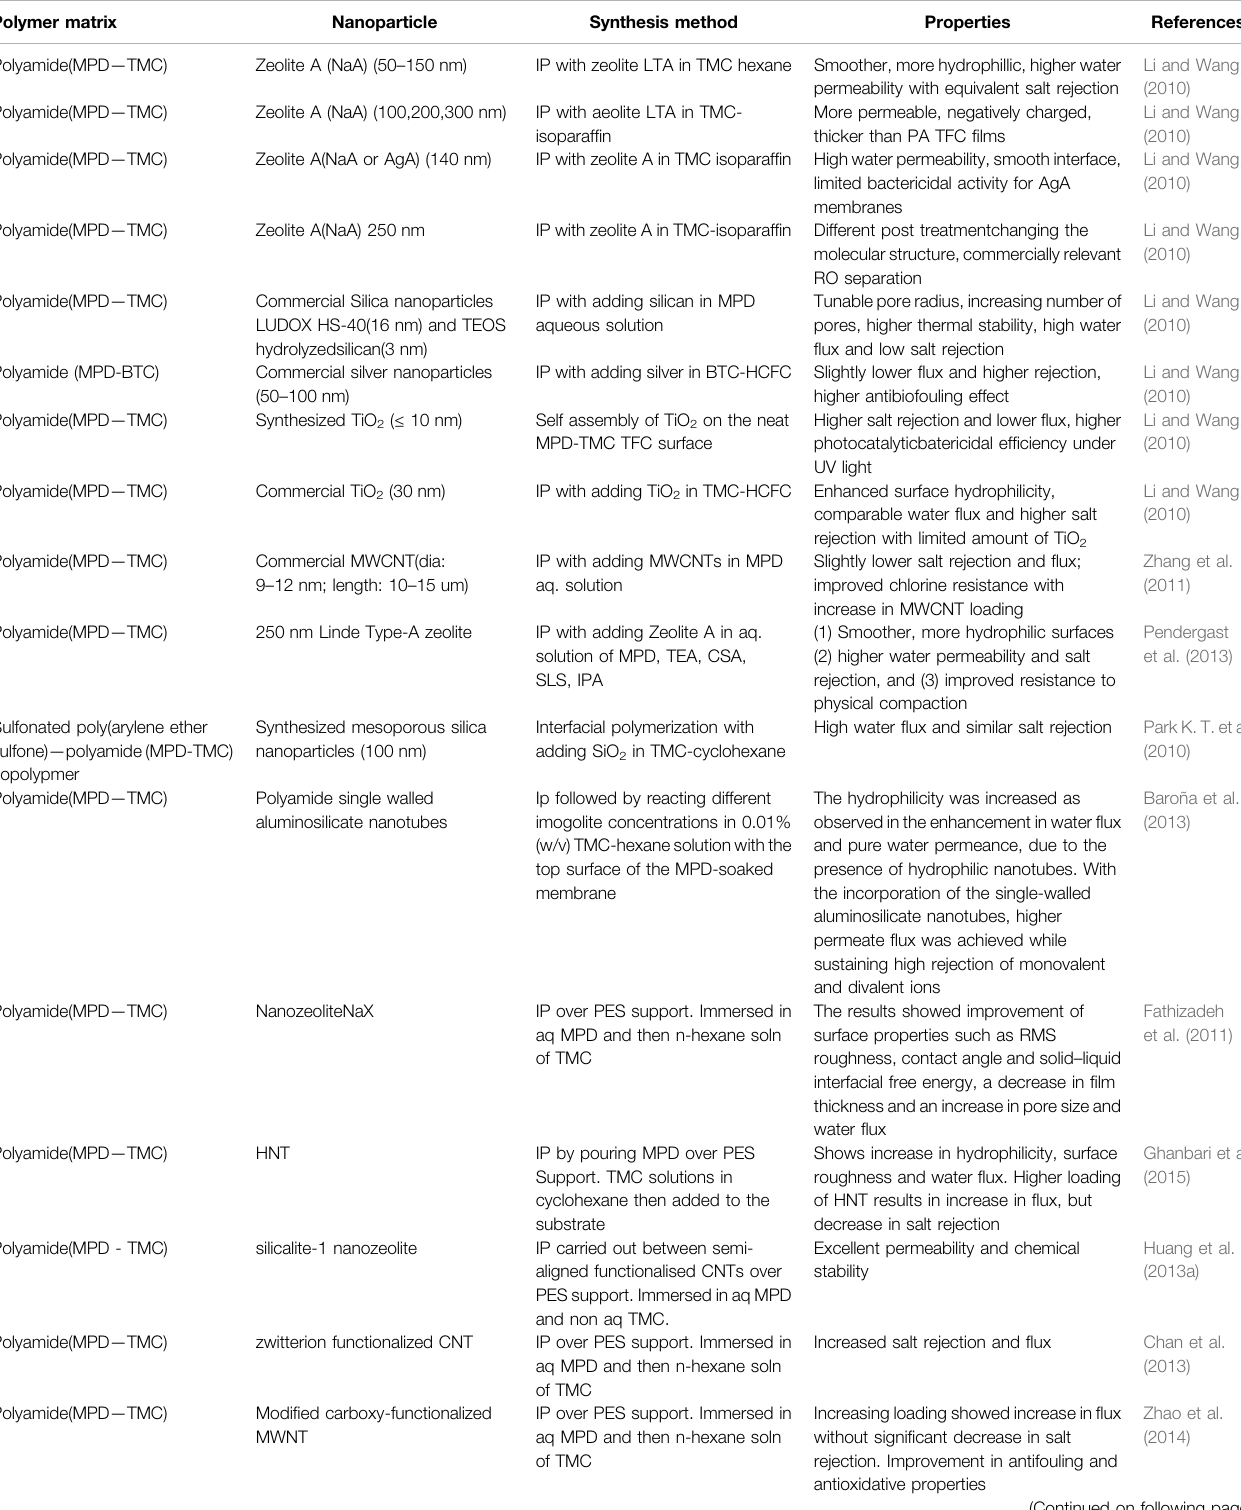
TABLE1| SynthesisandpropertiesofTFNs(Petersen,1993;Kimetal.,2004;Louieetal.,2006;GhoshandHoek,2009;JadavandSingh,2009;Zhouetal.,2009;ParkK.